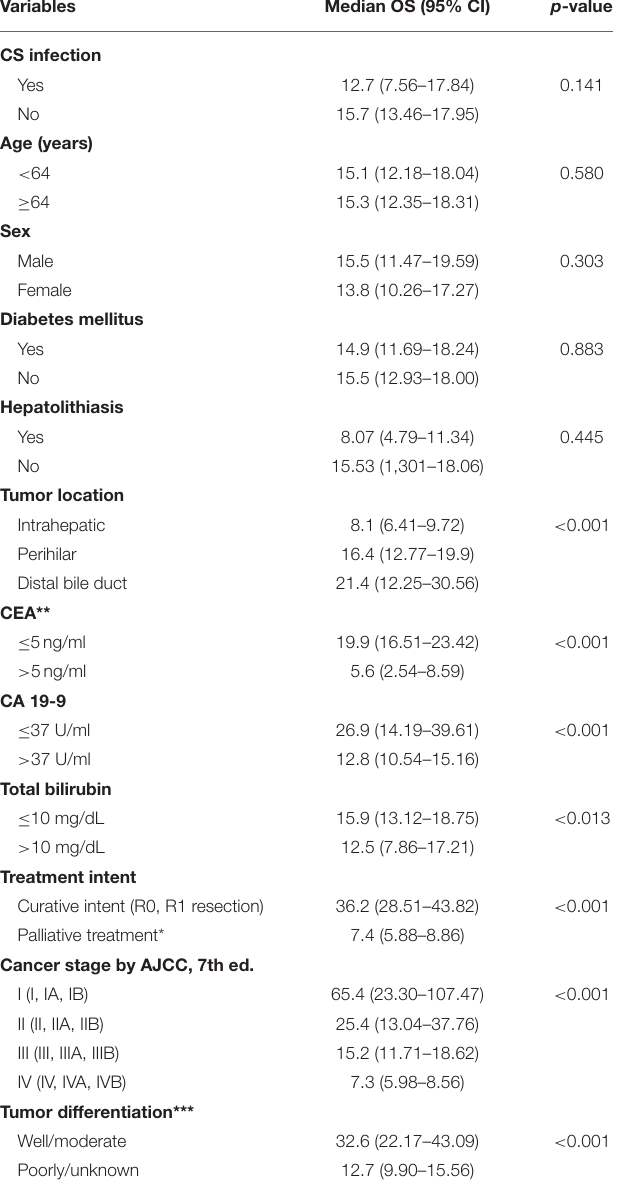
TABLE 4 | Multivariate analysis using the Cox proportional hazards M = model in cholangiocarcinoma patients.